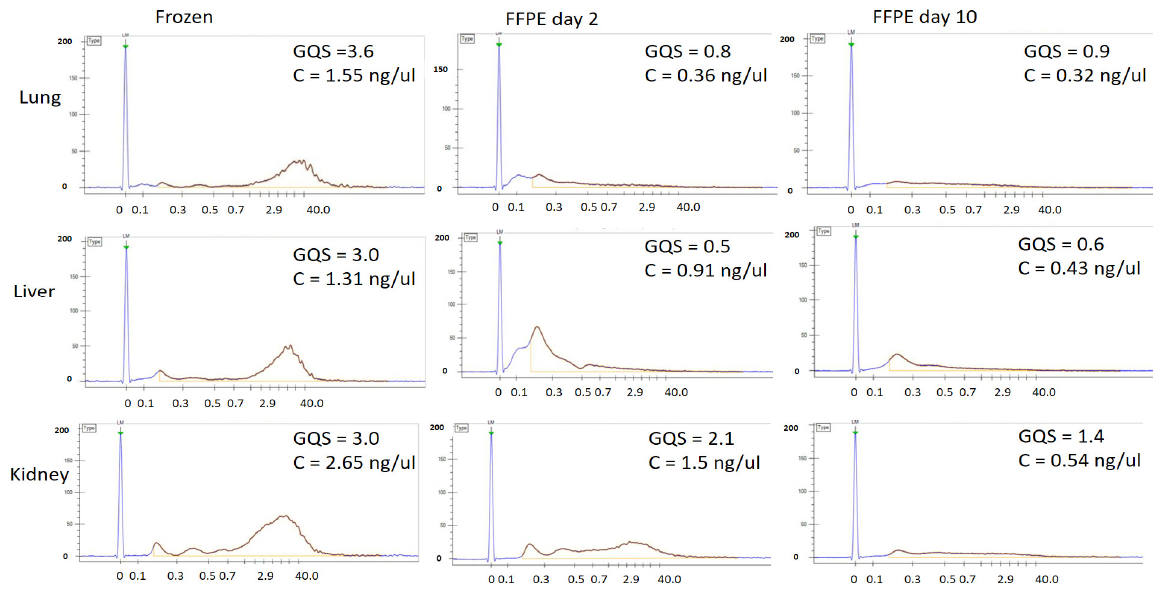
Figure 3. Genomic DNA integrity. Fragment length distributions and gDNA Quality Scores (GQS), of lung (top), liver (middle), and kidney (bottom) from one individual. The tissues were either frozen (left) or FFPE, following 2 (middle) or 10 (right) days of fixation. Presented is also the concentration (C) for the individual samples. y -axis = fluorescence intensity units, x -axis = fragment size